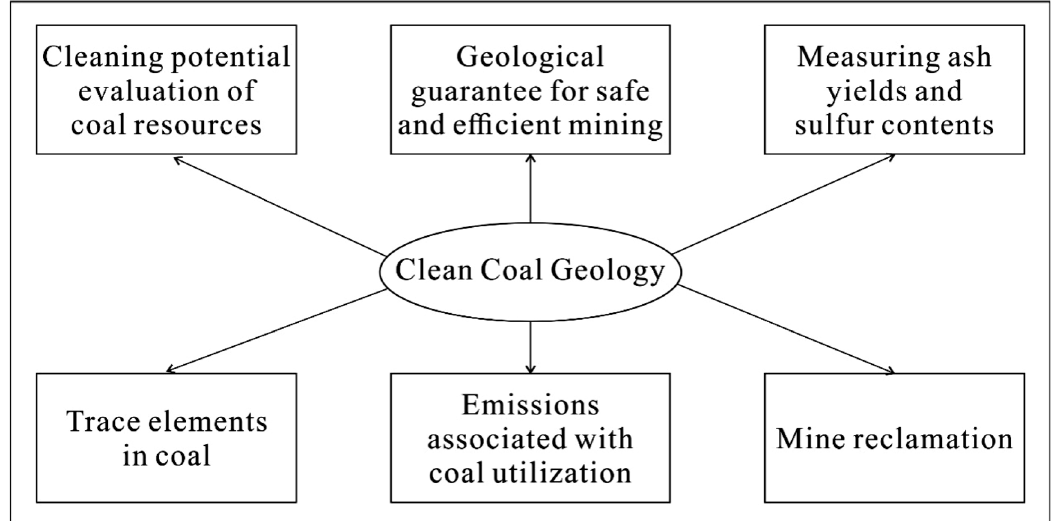
Fig. 1 Main directions of CCG